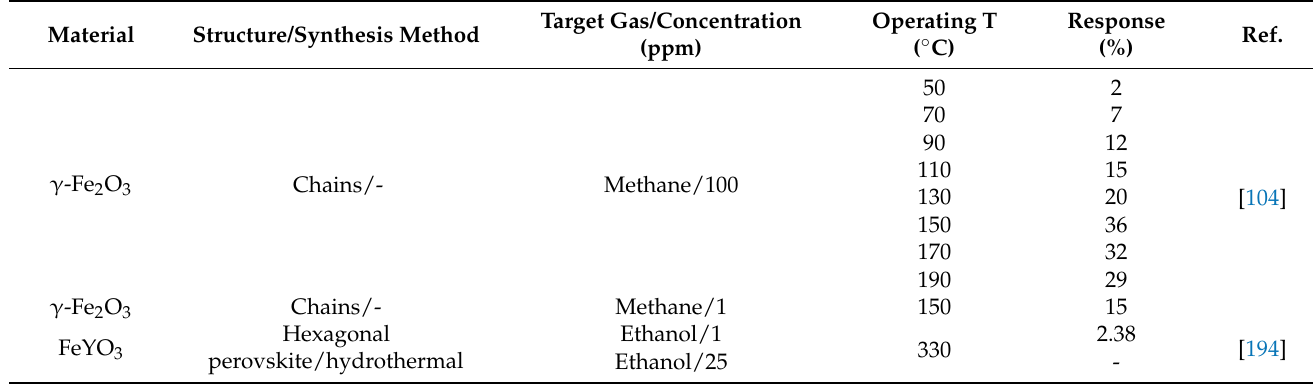
Table 7. Iron oxide nanoparticles were obtained using the green synthesis method. Material Structure/Synthesis